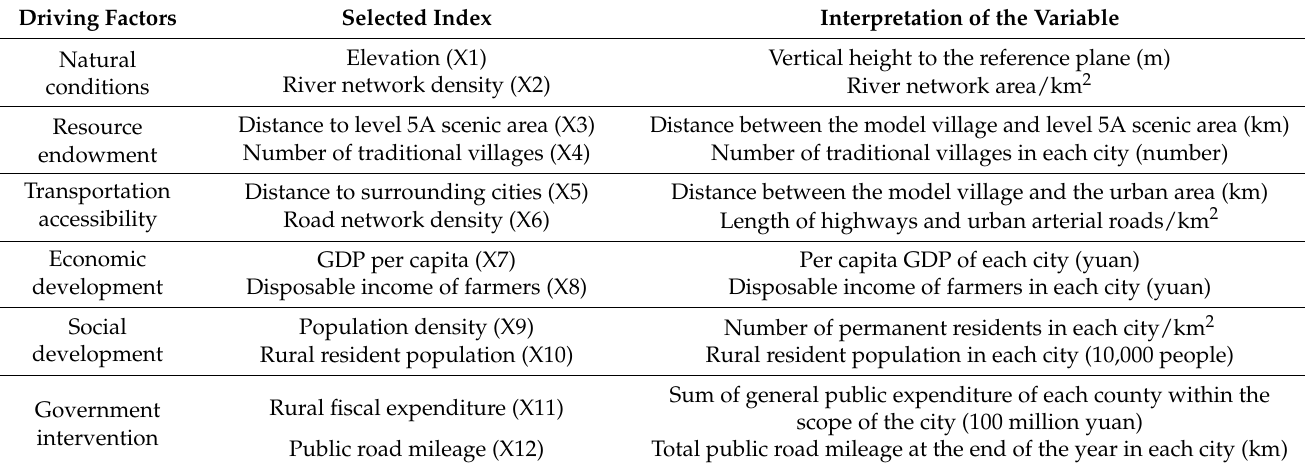
Table 3. The index system of the driving factors.